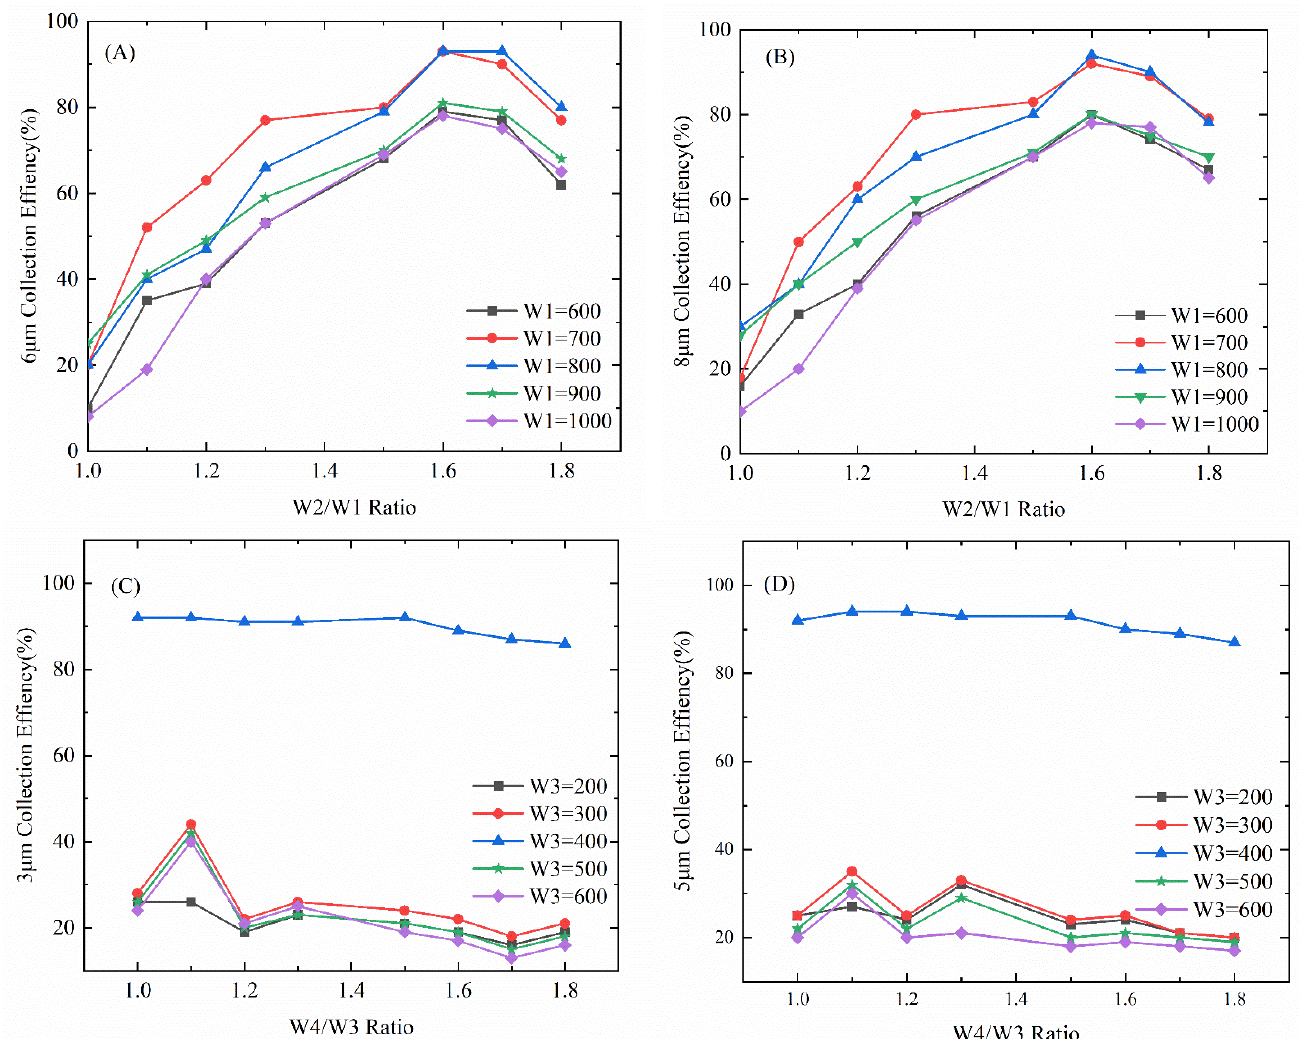
Figure 5. Statistical graph of particle enrichment imitation rate: ( A ) 6 μ m collection efficiency; ( B )